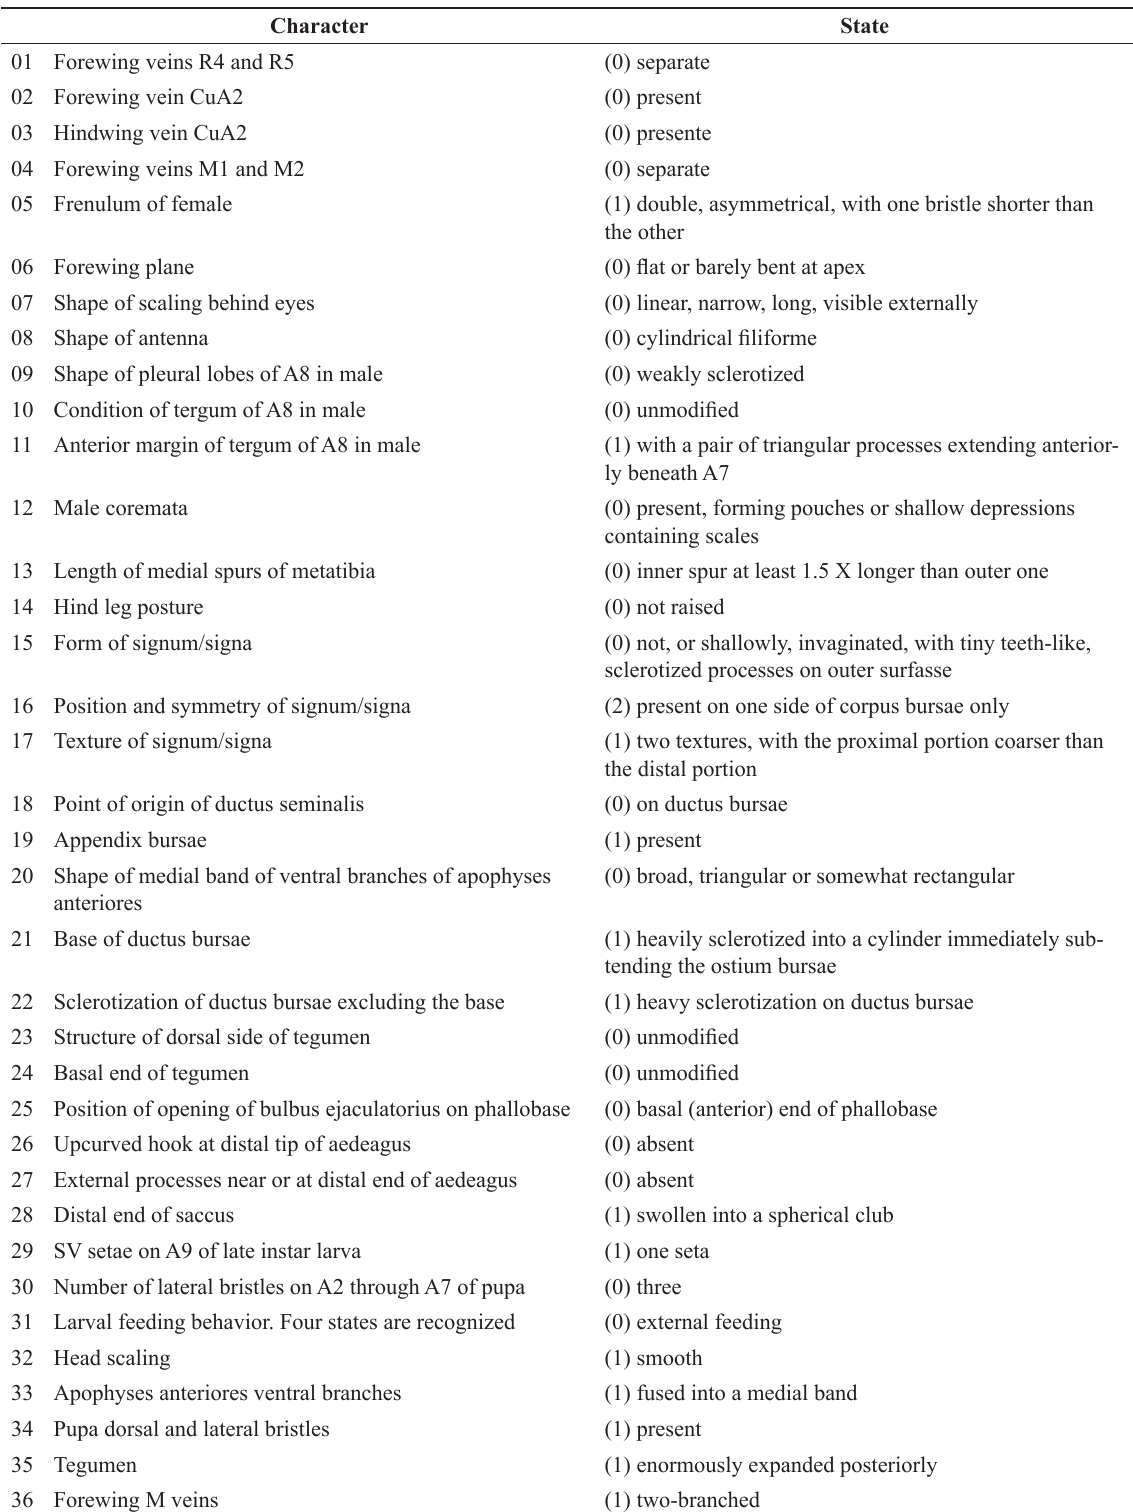
Table 1. Character states coded for Helioandesia tarregai gen. et sp. nov. included in the data matrix of Hsu & Powell (2004) for the cladistic